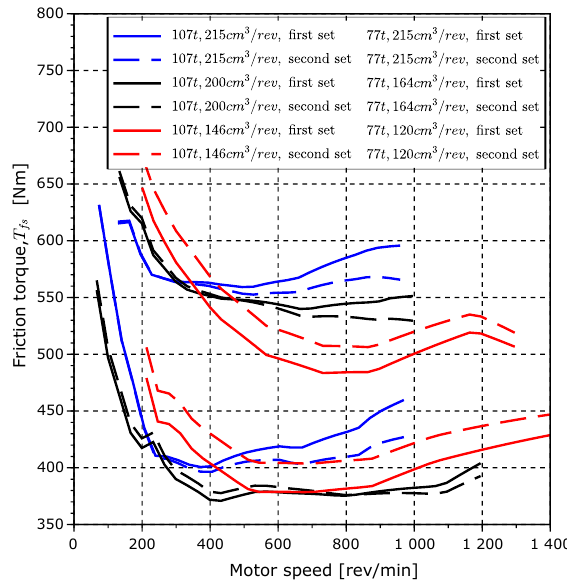
Figure 13: System friction calculated based on model versus efficiency map from supplier.